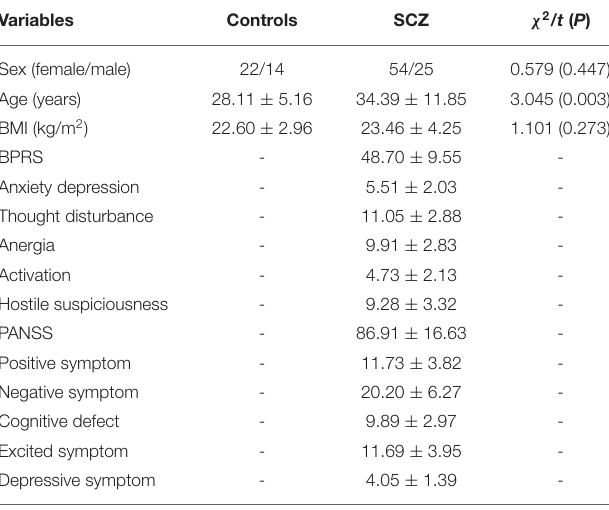
TABLE 1 | Comparison of demographic and clinical data between controls and first-episode drug naïve patients with SCZ.